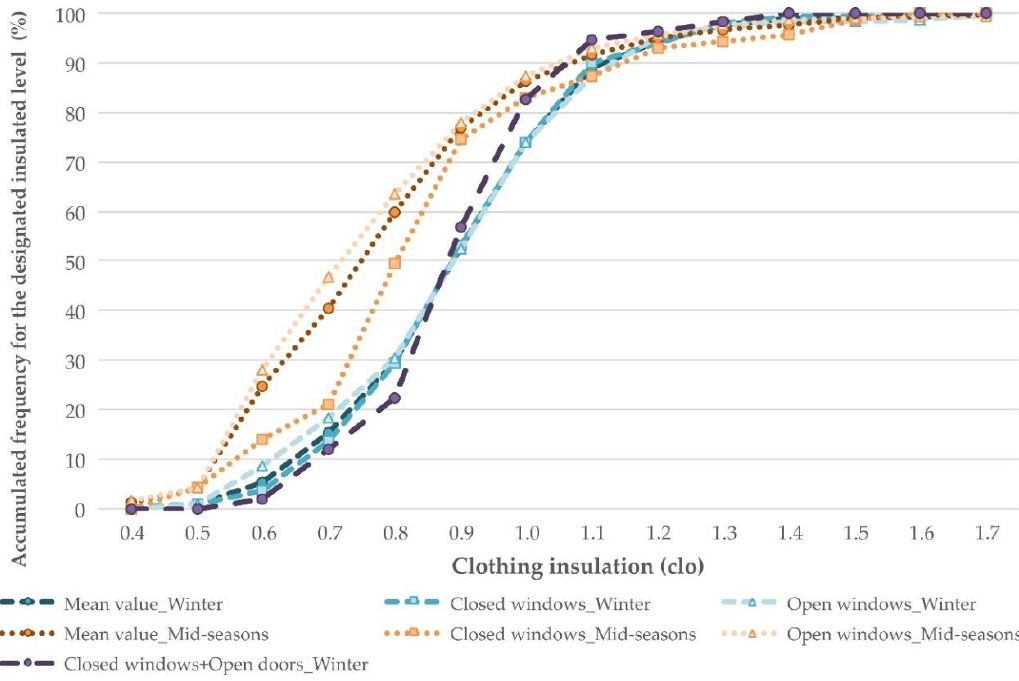
Figure 9. Accumulated frequency for the designed insulated level related to seasons and windows’ and doors’ operation.